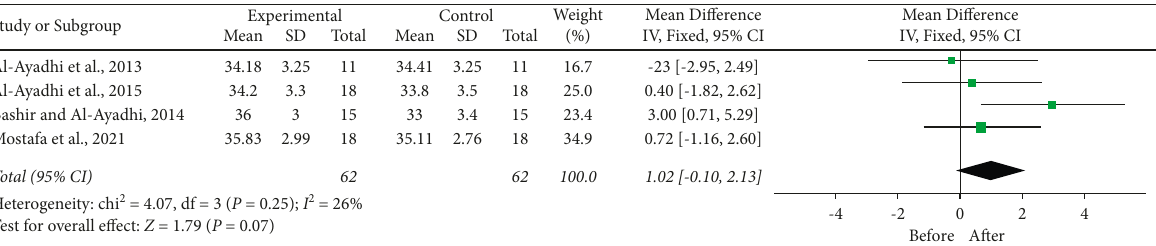
Heterogeneity: chi 2 = 8.12, df = 3 ( P = 0.04); I 2 = 63% Test for overall effect: Z = 3.55 ( P = 0.0004) Figure 4: Forest plot of the meta-analysis results showing the effects of treatment on ASD patients consuming boiled/pasteurized camel milk.